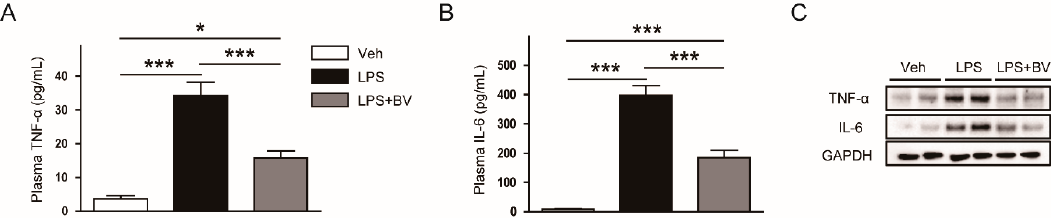
Figure 4. Bee venom reduced plasma and tissue levels of inflammatory cytokines in LPS-treated mice. ( A ) Plasma tumor necrosis factor- α (TNF- α ). ( B ) Plasma interleukin-6 (IL-6). ( C ) Representative images of Western blotting of TNF- α , IL-6, and GAPDH in kidneys. n = 8 per group. * p < 0.05 and *** p <